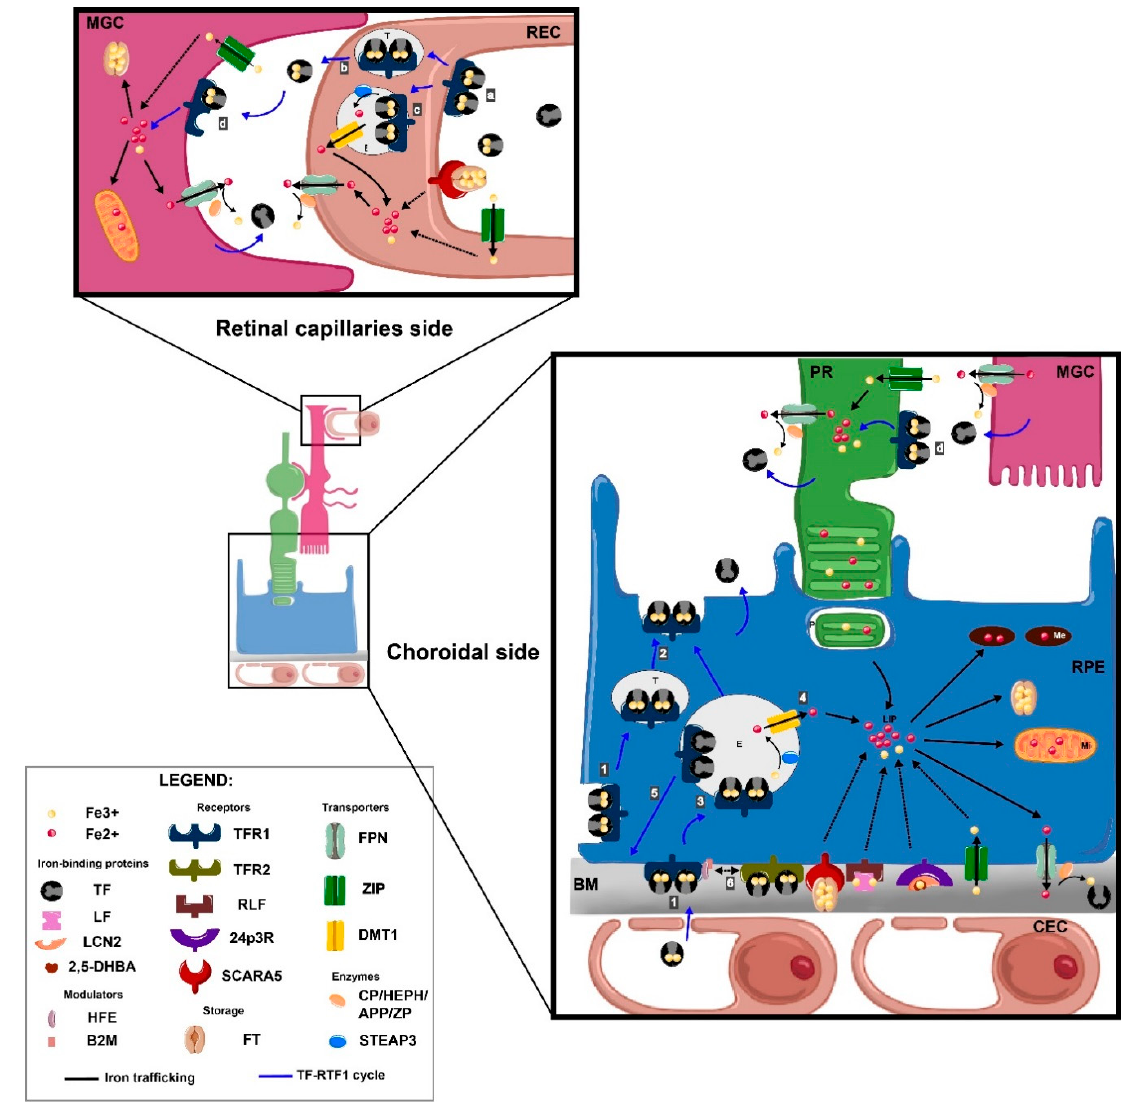
Figure 2. Iron uptake from capillaries and transport in the retina. Legend Figure 2: Under physiological condition, non-heme iron (Fe 3+ ) in the circulation is transported bound to transferrin (TF). A. At the choroidal side, Fe 3+ linked to TF is captured by its receptor 1 (TFR1) (1) at the basolateral level of the retinal pigment epithelium (RPE) (blue arrows). The internalized TF/TFR complex is transported to the apical pole by transcytosis (T) (2) or to the endosome (E) (3). In this case, Fe 3+ is released from TF and reduced by the metaloreductase six transmembrane epithelial antigen of the prostate 3 (STEAP3) to ferrous iron (Fe 2+ ) and then exported to the cytosol by the transporter divalent metal transporter 1 (DMT1) where it constitutes the free iron pool (LIP) (4). TF and TRF1 are recycled to membrane (5). Iron is then transported from LIP to the organelles as needed, either stored in ferritin (FT) and melanosomes (Me), or exported by ferroportin (FPN) coupled to ferroxidases such as ceruloplasmin (CP) or hephaestin (HEPH), amyloid-beta precursor protein (APP) or zyloklopen (ZP) (black arrows). Hemochromatosis protein (HFE) and beta-2 microglobulin (B2M) associated to TFR1, shift to TFR2 in case of iron overload (saturation of TF) and activate hepcidin (HEPC) transcription (6). B. At retinal capillaries side, Fe 3+ bound to TF is up-taken by TFR1 at the luminal side of retinal endothelial cells (REC) (a), and TF/TFR1 pass directly through transcytosis into the retina (b) or endocytosed then exported by FPN (c). TF synthetized by RPE, Müller glial cells (MGC) or